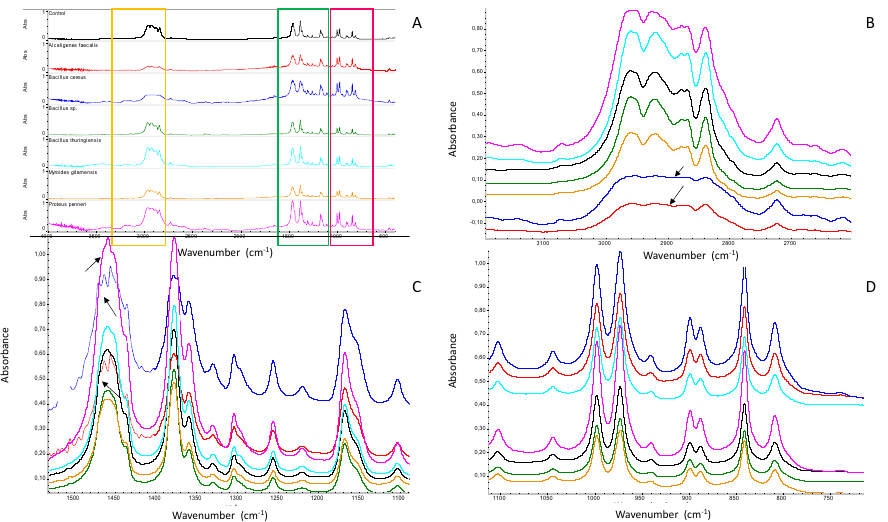
Figure 1. FTIR spectra of whole spheres of polypropylene (PP). ( A ) Spectra from polymers without inoculum (control) and with each one being bacteria inoculated; ( B ) Detail of spectra in vibration band between 3100 and 2500 cm − 1 ; ( C ) Detail of spectra in vibration band between 1600 and 1000 cm − 1 ; ( D ) Detail of spectra in vibration band between 1100 and 750 cm − 1 . Red line corresponds to PP whole spheres inoculated with Alcaligenes faecalis , blue line with Bacillus cereus , green line with Bacillus sp., light blue line with Bacillus thuringiensis , orange line with Myroides gitamensis , pink line with Proteus penneri and black line corresponds to PP spheres without inoculum (control). Arrows are indicative of flattening peak (in B ) and double peaks (in C ).